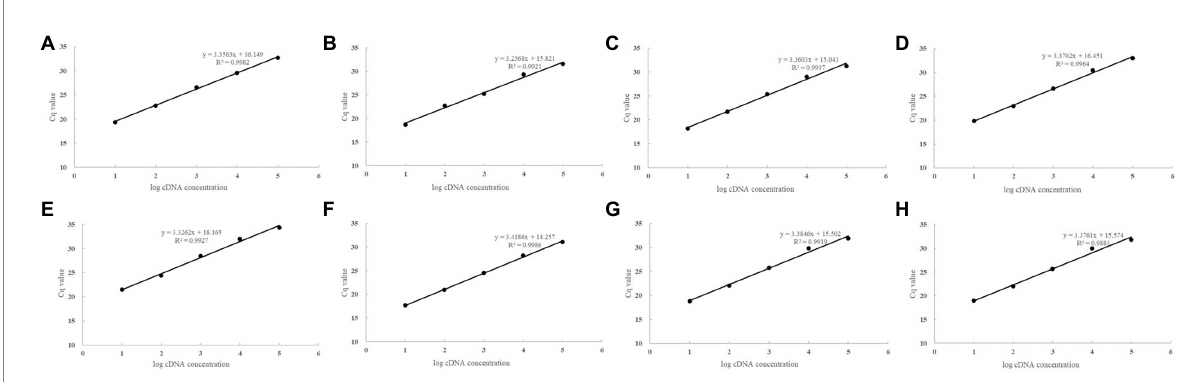
FIGURE 1 Standard curve of Colletotrichum fructicola RT-qPCR quantitative primers. The primer efficiency for the RT-qPCR quantification of the gene was determined using a serial dilution of cDNA templates from conidia. The respective correlation coefficients (R 2 ) are indicated. (A) CfTub ; (B) CfAct ; (C) CfDd ; (D) CfCk ; (E) CfRpp ; (F) CfUce ; (G) CfRrp ; and (H) CfAdrh.